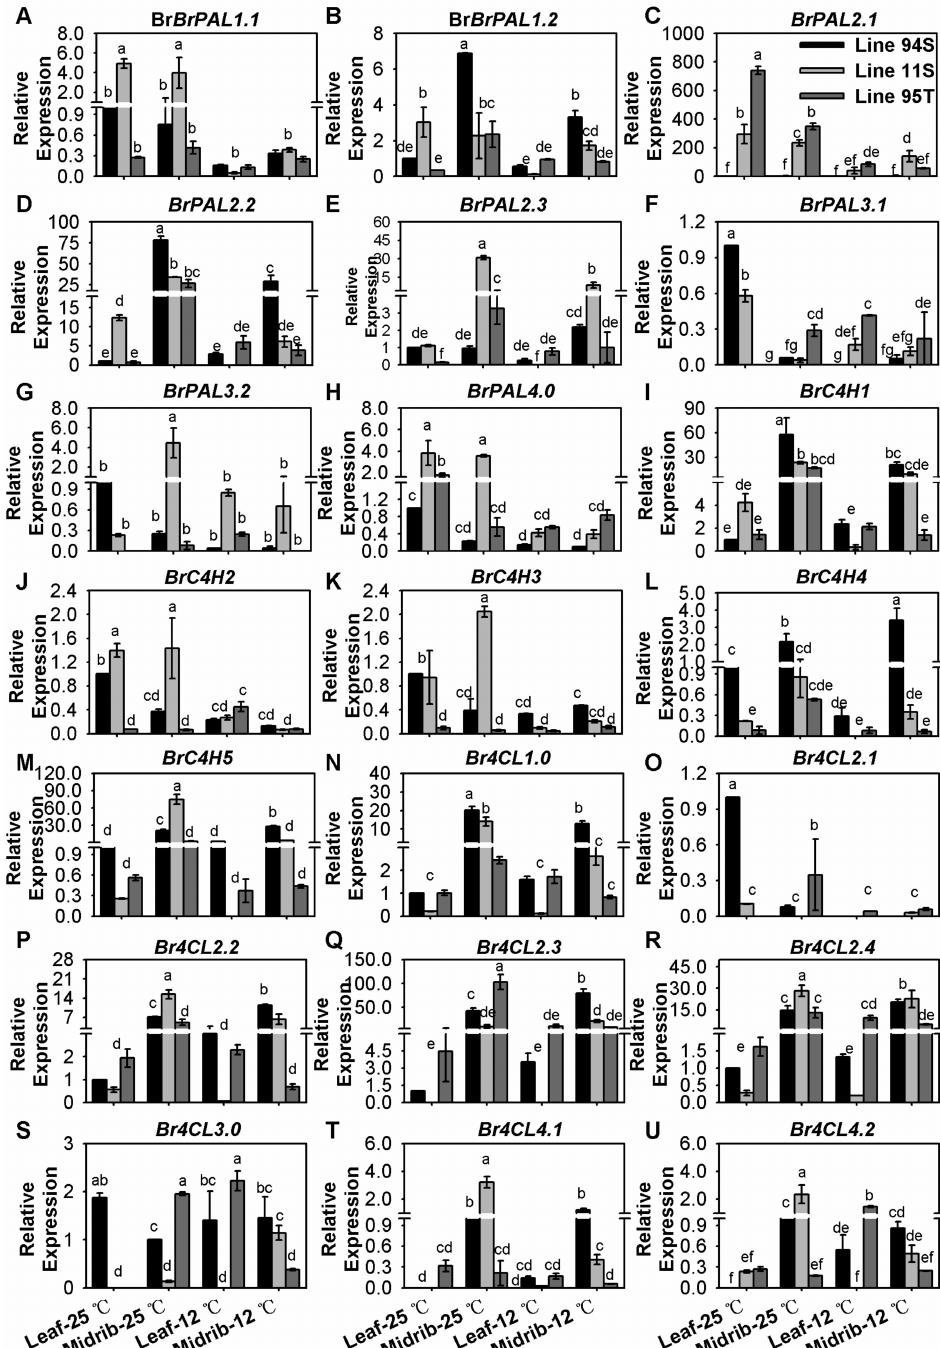
Figure 2. Expression of phenylpropanoid metabolic pathway genes (PMPGs) in the seedlings of three Chinese cabbages under low temperature treatment. ( A – H ) relative expression of BrPALs ; ( I – M ) relative expression of BrC4Hs ; ( N – U ) relative expression of Br4CLs . Plants of three lines were grown under a 12-h light photoperiod at 25 ◦ C, 125 mmol m − 2 s − 1 ; 28-day seedlings were treated at 12 ◦ C for 15 days, and seedlings that stayed at 25 ◦ C with same light condition were treated as the control. Seedling leaves were divided into the midribs and the leaves, and leaves of Line94S at 25 ◦ C served as the control. Values are presented as means ± SD ( n = 3). The di ff erent letters above each column are significantly di ff erent at p < 0.05 by Duncan’s